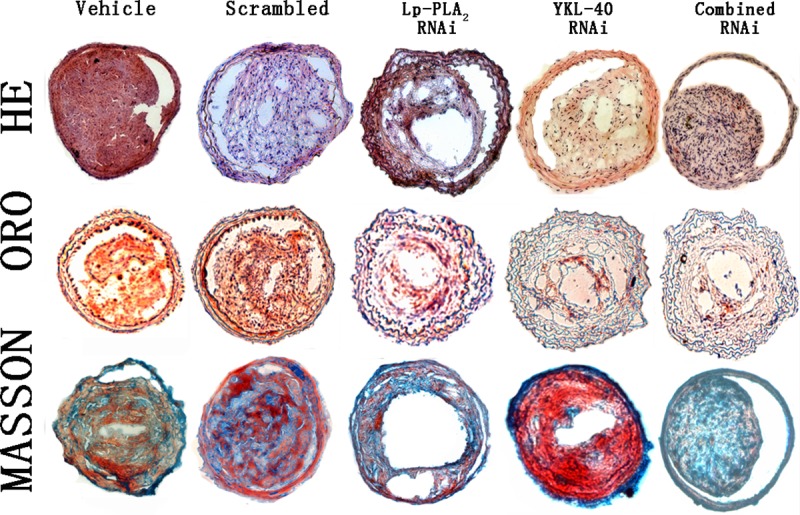
Plaque morphology of the vehicle, scrambled, Lp-PLA2 RNAi, YKL-40 RNAi, and combined Lp-PLA2 and YKL-40 RNAi groups.Cross-sections of plaques from all groups were stained with HE, ORO and Masson’s trichrome (n = 12). Magnification 200×.